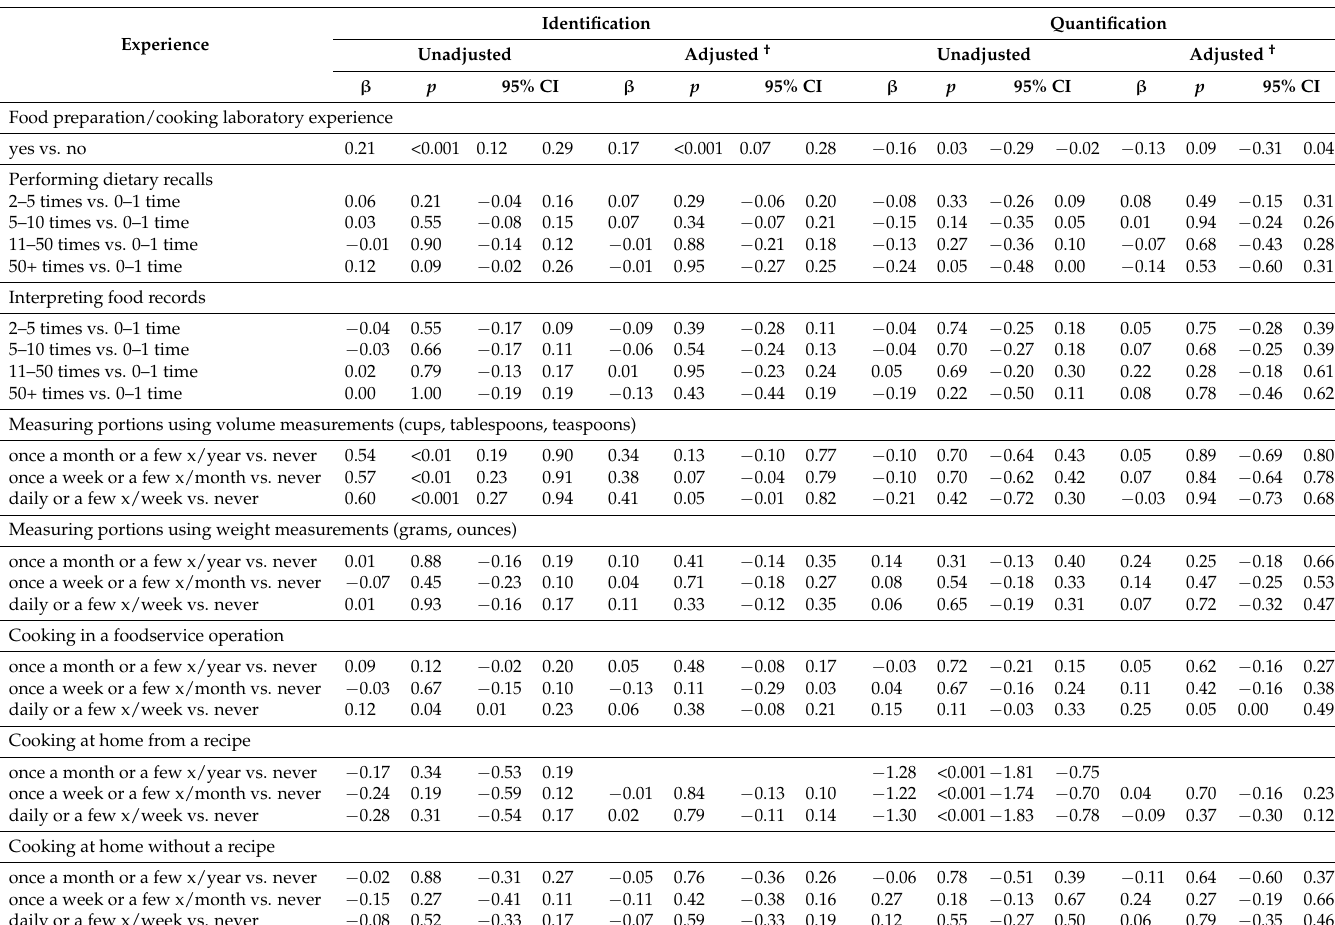
Table 4. Linear regression analysis for experiences of participants relating to the ability to identify foods from digital images (percent of foods identified correctly) and quantify foods from digital images (average percent error).